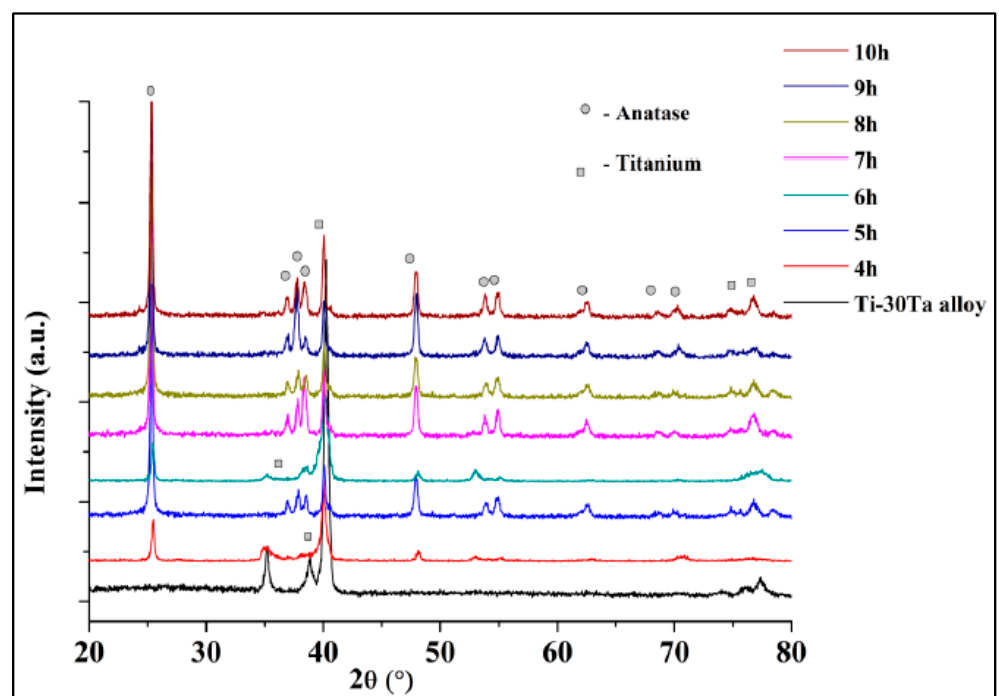
Figure 3. X-ray diffraction analysis (XRD) patterns of Ti-30Ta alloy and after anodization process in NH 4 F 0.25% + glycerol at 30 V for 4, 5, 6, 7, 8, 9, and 10 h. The annealing process was performed at 530 ◦ C (5 ◦ C / min) for 1 h. We observed anatase formation for all conditions except the control group. Metals 2020 , 10 , x FOR PEER REVIEW